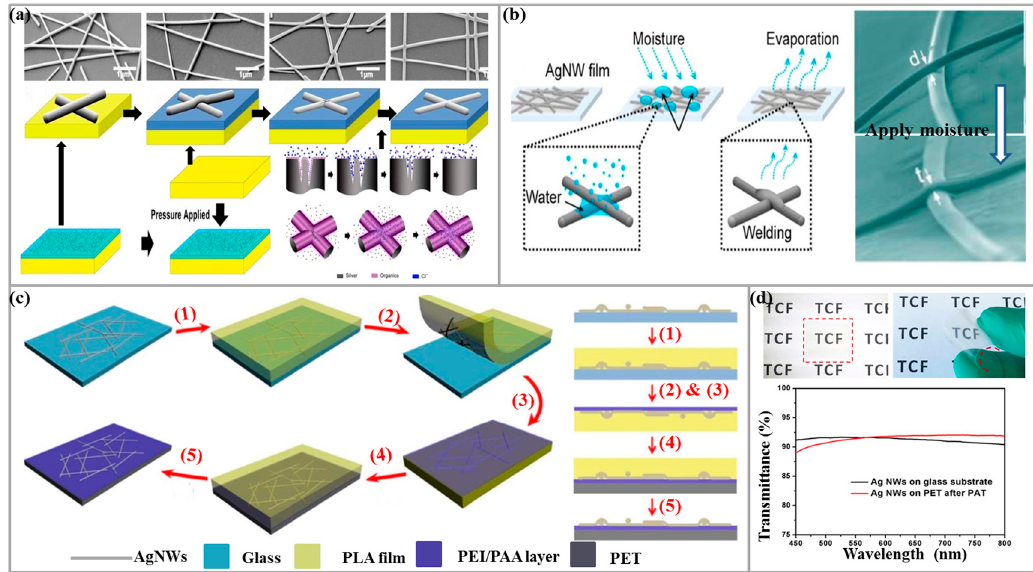
Figure 5. Solutions to the problems of high junction resistance, poor mechanical stability and poor thermal/environmental stability in Ag NWs TCE preparation: ( a ) SEM images of pristine Ag NWs ， NaAlg/Ag NWs composite film, NaAlg/Ag NWs composite film after mechanical pressing and NaAlg/Ag NWs composite film after mechanical pressing and CaCl 2 treatment and the schematic diagrams of junction between Ag NWs corresponding to SEM images, and the schematic illustration of a possible mechanism of crack renovation [104]. Copyright 2017, ACS Applied Materials and Interfaces. ( b ) Schematic of moisture treatment for capillary-force-induced cold welding of Ag NWs [103]. Copyright 2017, Nano Letters. ( c ) The 3D (left) and sectional (right) schematic peel-assembly-transfer (PAT) procedure for the insertion of the PEI/PAA adhesion multilayer between Ag NWs and PET substrates. ( d ) The prepared Ag NWs TCF on PET substrate indicating that the film is transparent and flexible, and the transmittance spectra of the Ag NWs network before and after PAT process [109].